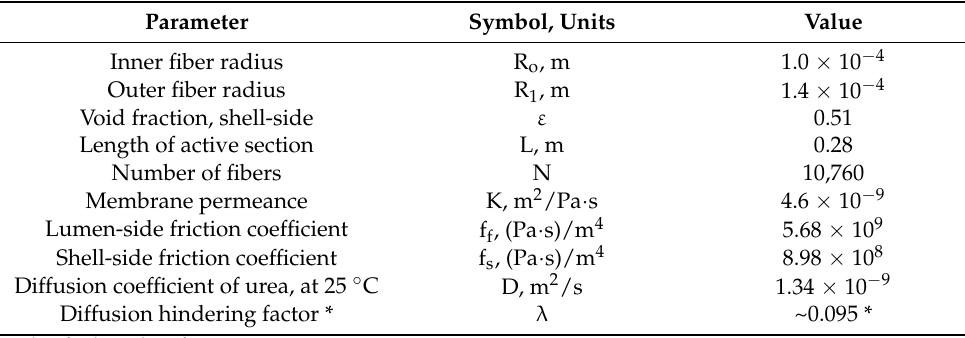
Figure 8. Measured (in triplicate) local urea concentration C D in the shell side of the module. Case (III): flow rates Q Blood = 300 mL/min, Q Dialysate = 500 mL/min. Table 2. Input parameter values for mass transfer